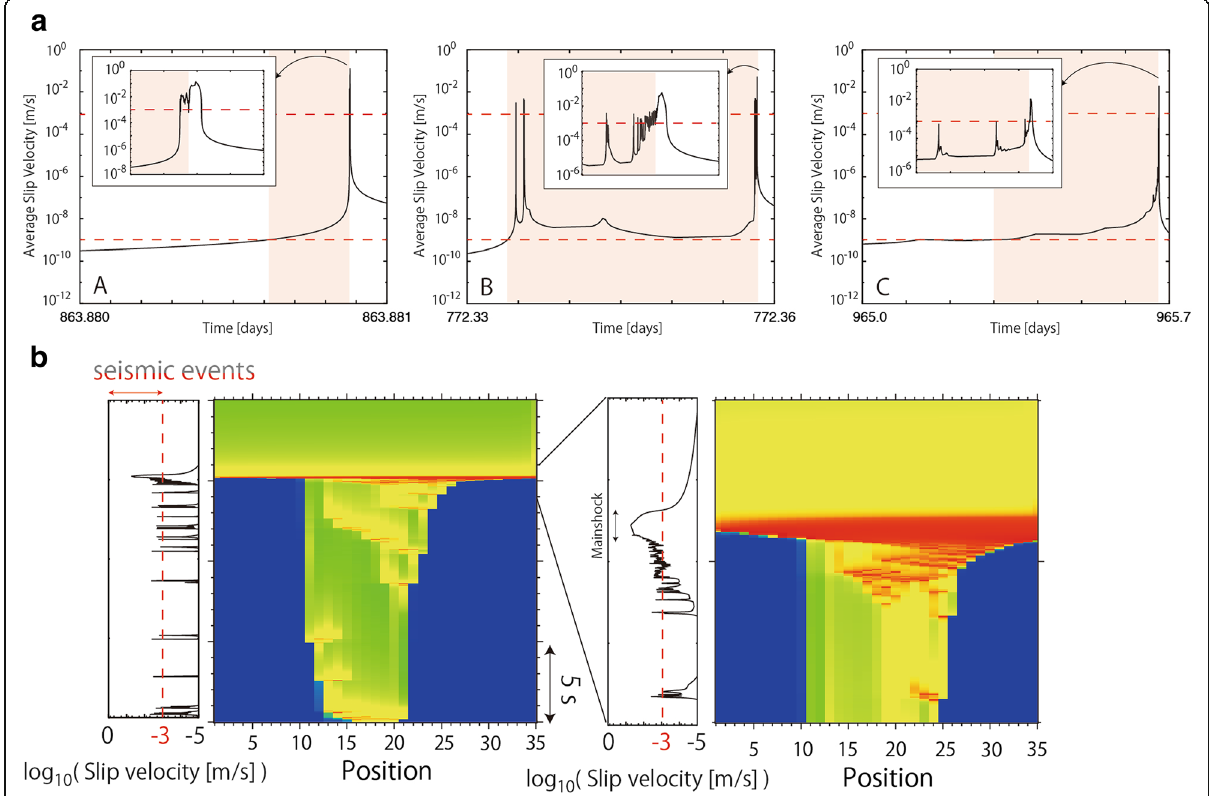
Fig. 5 Definitions of precursory periods and foreshocks. a Temporal evolution of average slip velocities of events for parameter sets A – C in Fig. 3. Insets show close-ups of the time periods around the mainshock. Red hatched time periods are the defined precursory periods. b Slip velocity distributions for parameter set B of Fig. 3 with average slip velocities. Foreshocks are defined when the average slip velocity exceeds 1 mm/s. The right panel is a close-up of the time window around the